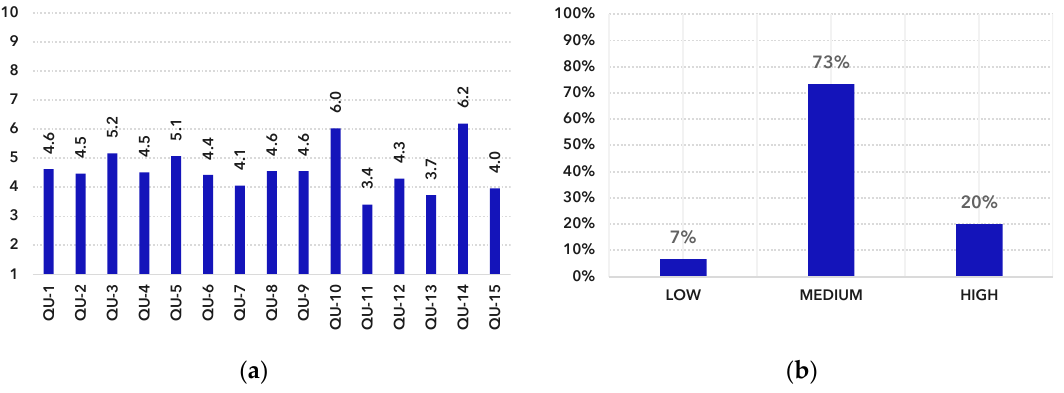
Figure 8. ( a ) Total vulnerability index graph; ( b ) Percentage distribution of the total vulnerability index values.